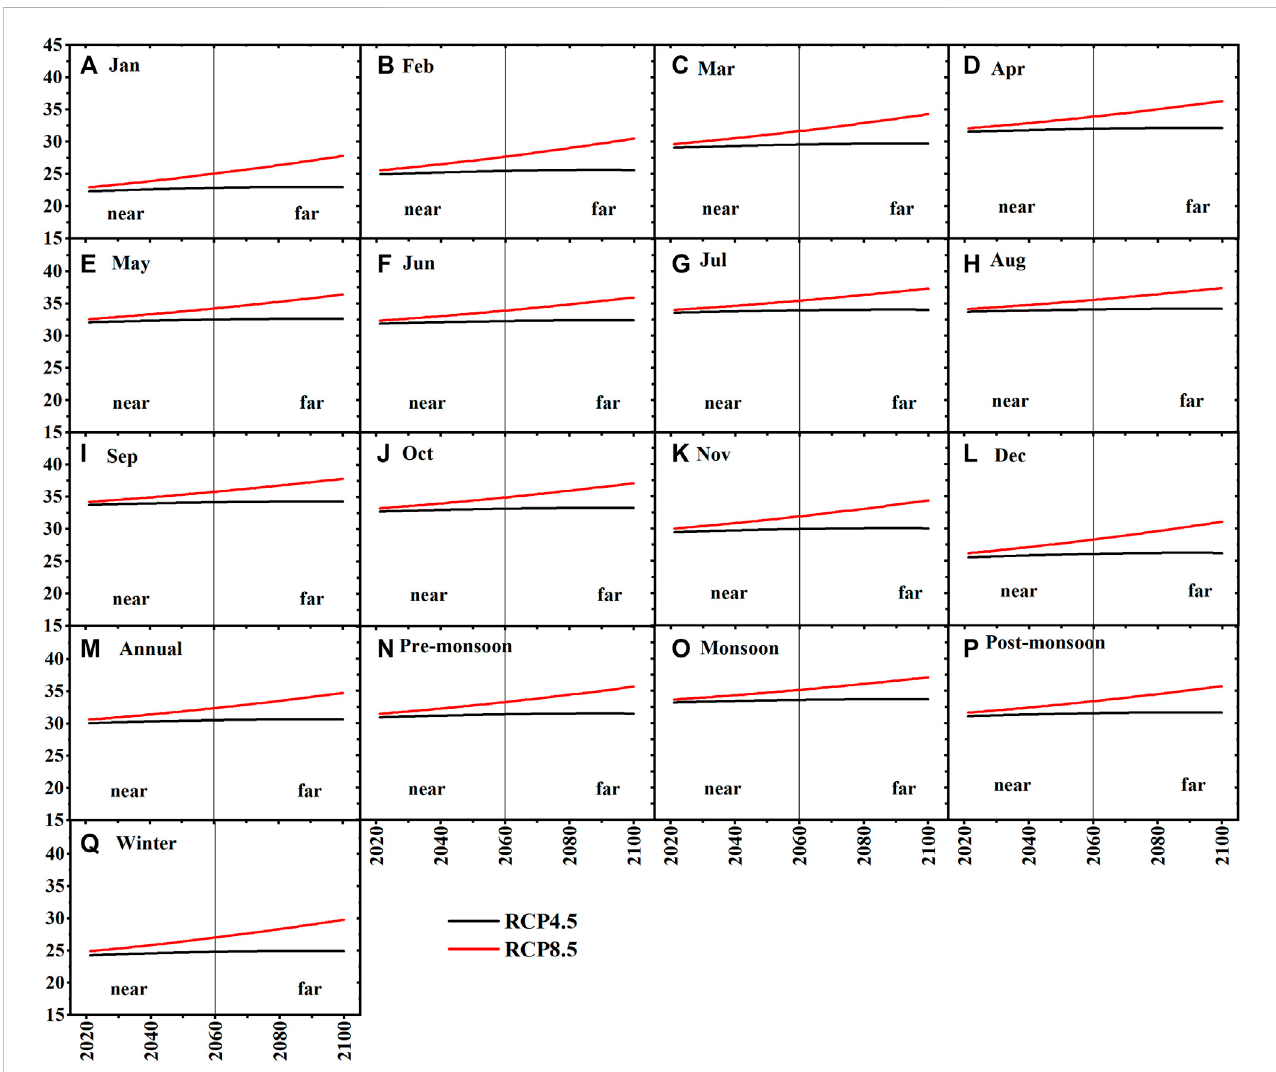
FIGURE 9 Monthly, Annual and Seasonal Tmax ( o C) variability of multi-model ensemble (MME) of CMIP5 datasets under RCP4.5 and RCP8.5 for the near and far periods in Bangladesh. (A) January, (B) February, (C) March, (D) April, (E) May, (F) June, (G) July, (H) August, (I) September, (J) October, (K) November, (L) December, (M) Annual, (N) Pre-monsoon, (O) Monsoon, (P) Post-monsoon, and (Q)